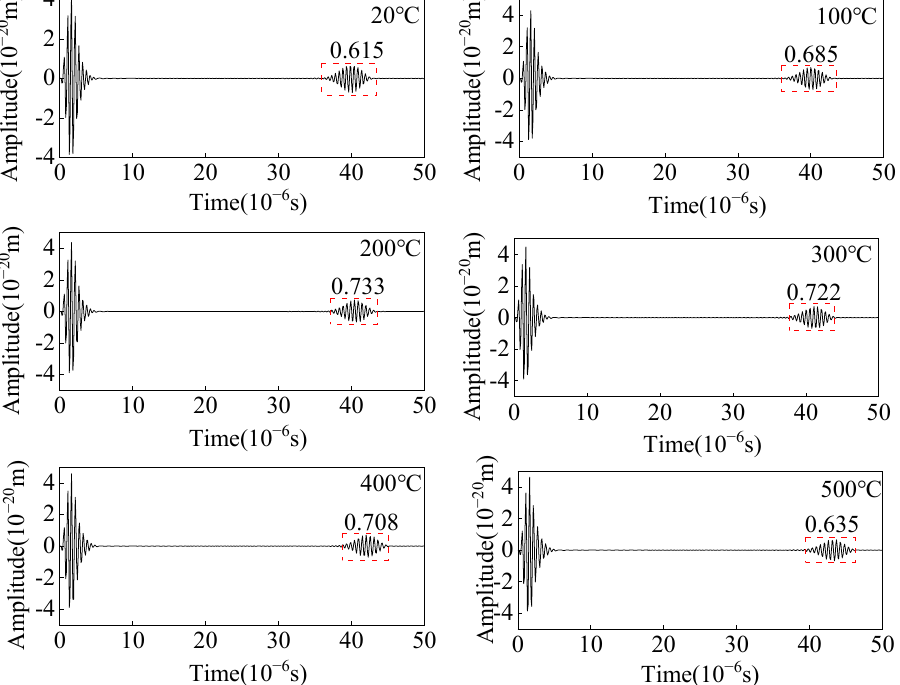
Figure 10. Ultrasonic displacement signal from angled SV wave EMAT in carbon steel specimens at different temperatures.